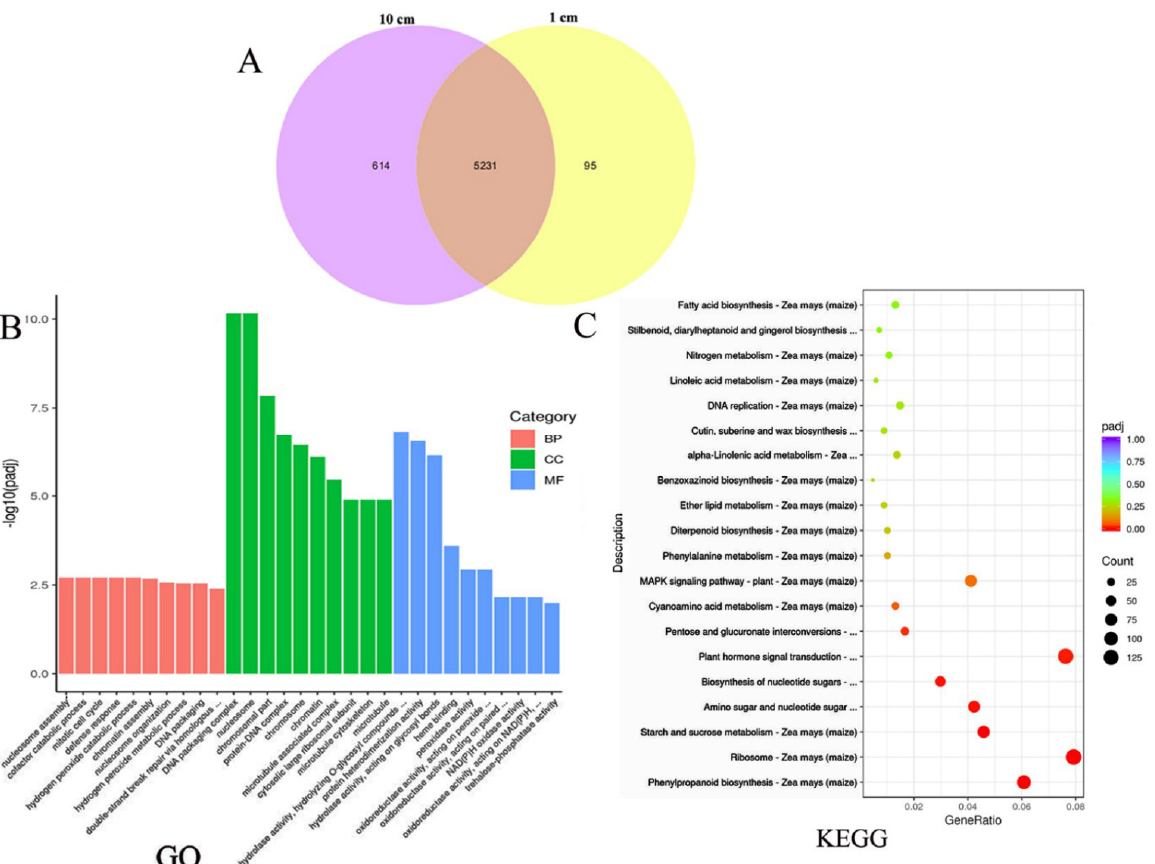
Figure 5. Analysis of transcription differences in mesocotyls of Ltx05 at 1 and 10 cm sowing depths. ( A ) DEGs identified under different sowing depths; ( B ) GO analysis; and ( C ) KEGG analysis.